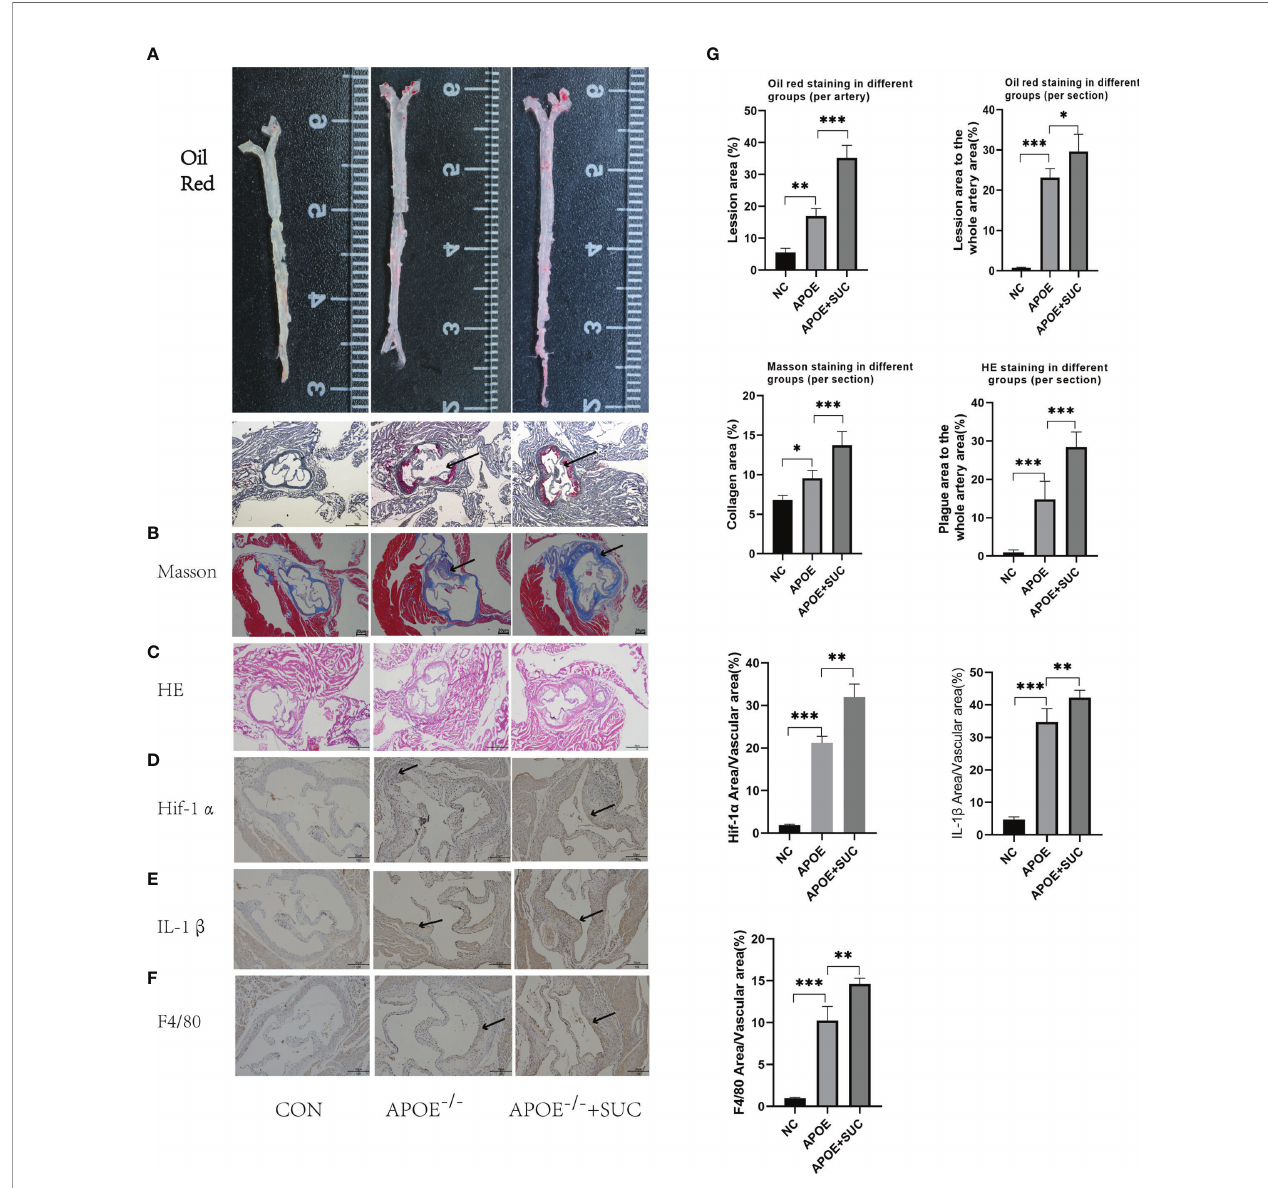
FIGURE 9 | Succinate/IL-1 b signal axis in atherosclerosis model (stainings). (A, B) Representative images of Oil Red O staining of the whole aorta (n = 3, per group) and aortic roots (n = 6 – 9, per group). (C) Representative images of H&E staining aortic roots (n = 6 – 9, per group). (D) Representative images of Masson staining aortic roots (n = 3 – 5). (E – G) Representative images of Hif-1 a , IL-1 b , and F4/80 staining aortic roots (n = 5 – 9). The areas of lesion or target proteins were marked with black arrows. (A – C) Magni fi cation ×40; (D – F) magni fi cation ×100. * P < 0.05; ** P < 0.01; *** P <